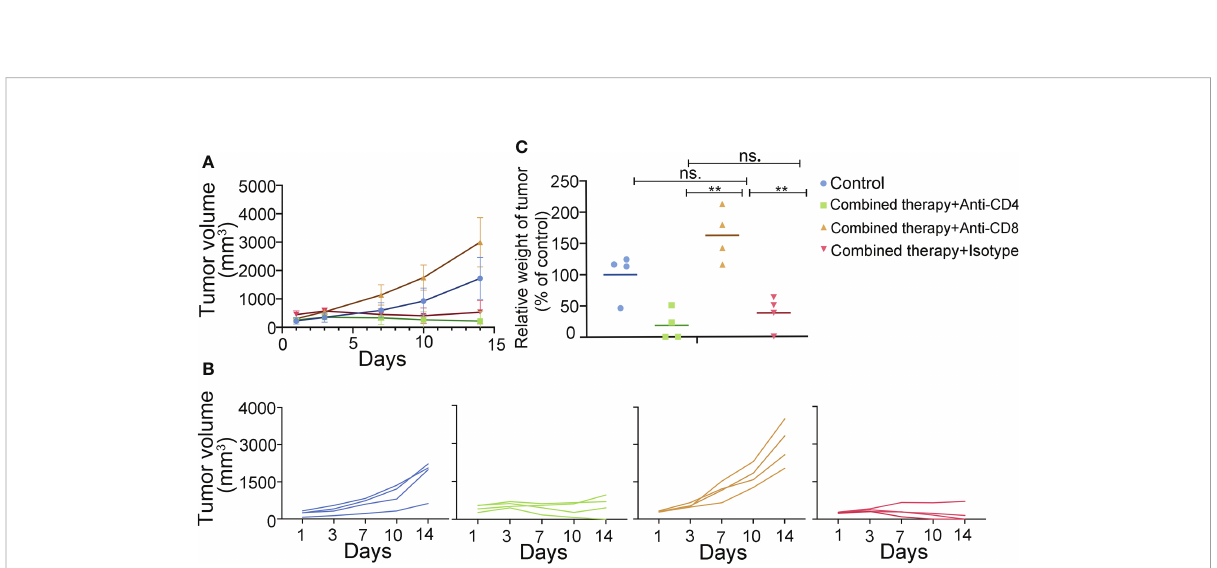
FIGURE 5 T cell subsets in the antitumor ef fi cacy of anti-PD-L1 mAb combined with 4-1BB agonist. The antitumor effect of the combined therapy was abolished by CD8 + T cell depletion. (A, B) Tumor volume was measured twice a week. (C) Tumor weight was measured at the end of the treatment. (n = 4, mean ± SD). ** means p-value < 0.01. ns means no signi fi cance.